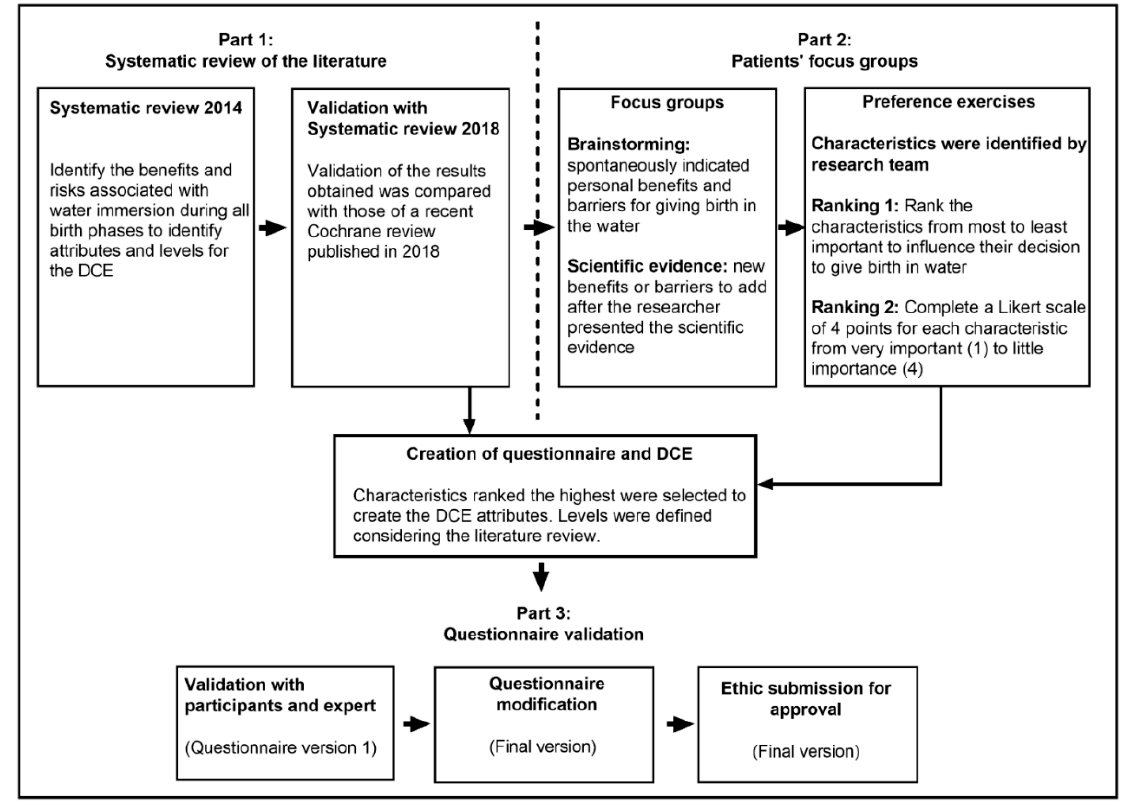
Figure 1. Mixed-methods approach, combining systematic reviews and patient focus groups to identify attributes and levels explaining women's preferences for birth in water.